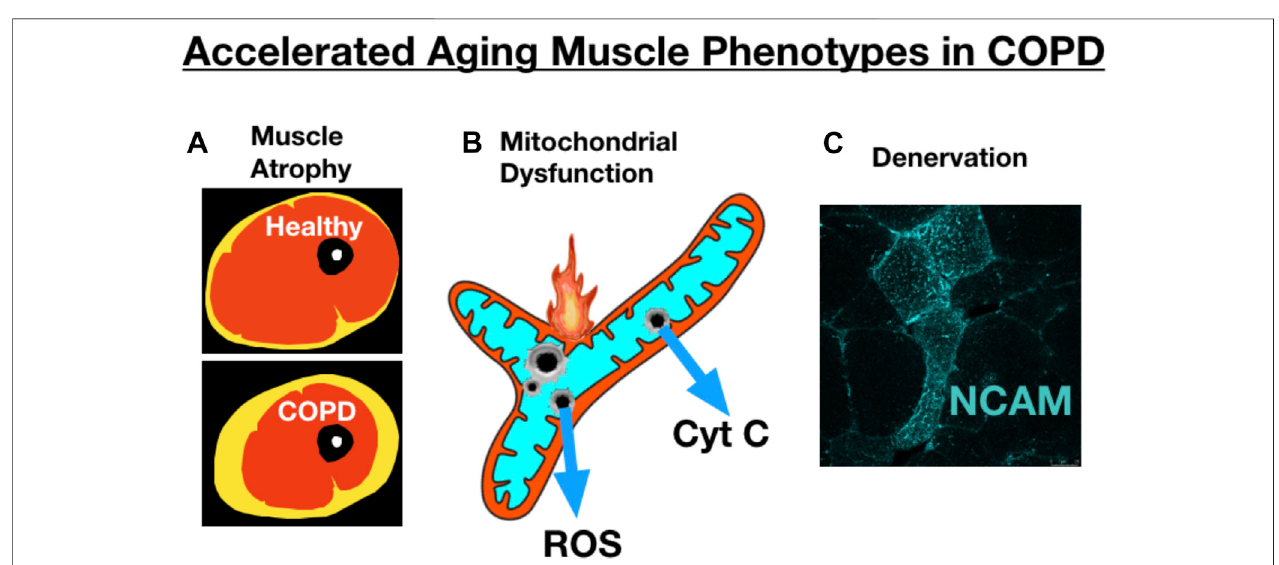
Frontiers in Physiology |